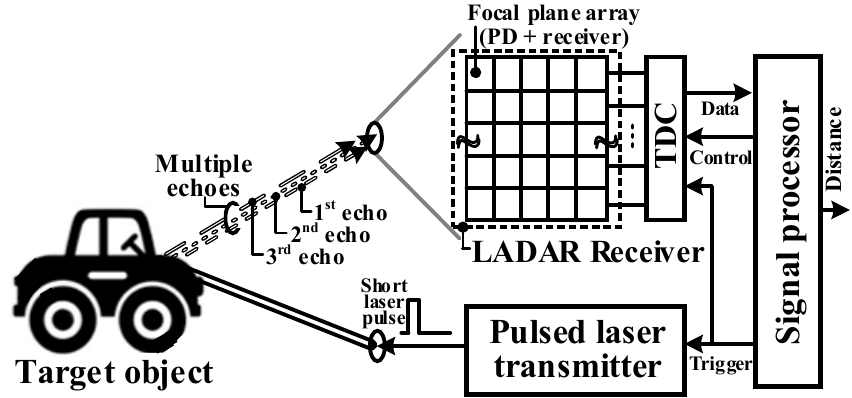
Figure 1. Block diagram of the typical pulsed time of flight (ToF) laser detection and ranging (LADAR) system. PD: photodiode; TDC: time-to-digital converter.